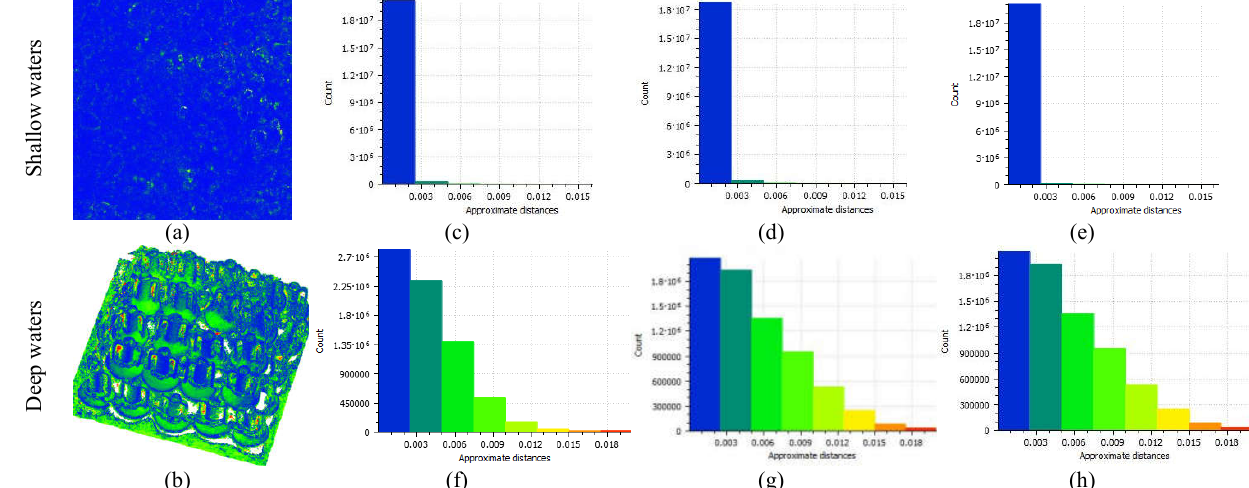
Figure 11: 3Dpc comparisons in Cloud Compare: Examples of the results of the comparison of the 3Dpc of the shallow and deep site (a,b) and histograms of deviations from the 3Dpc of the original images for shallow waters: CLAHE-shallow(c), Bianco et al. (2015)(d), Photoshop (e) and for deep waters: : CLAHE-shallow(f), Bianco et al. (2015)(g), Photoshop